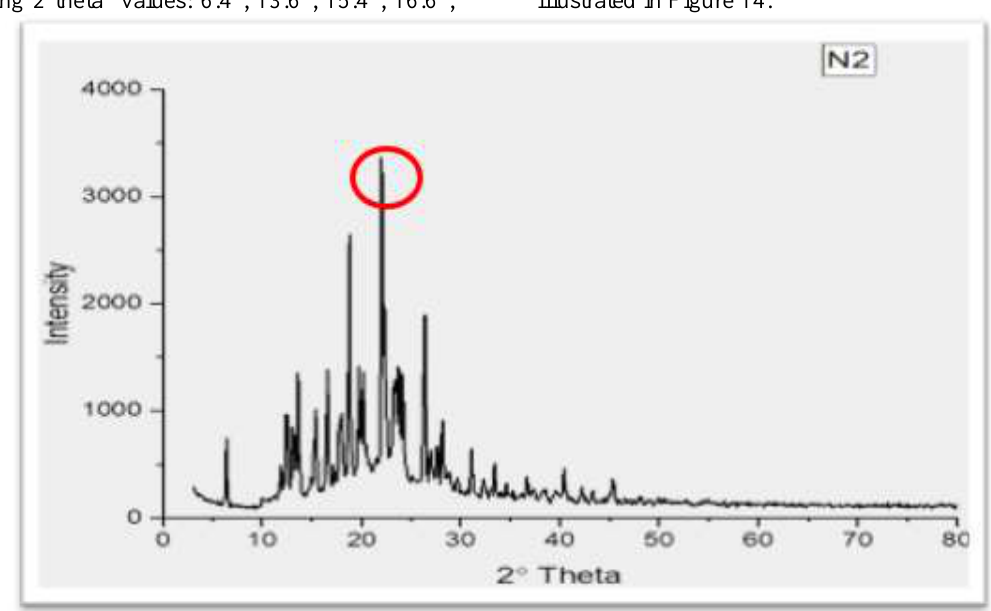
Figure 13.X-ray powder diffraction pattern of N1. The characteristic peaks of the (2:1) paracetamol-naproxen co-crystal (N2) were at the following 2 theta° values: 6.4°, 13.6°, 15.4°, 16.6°,